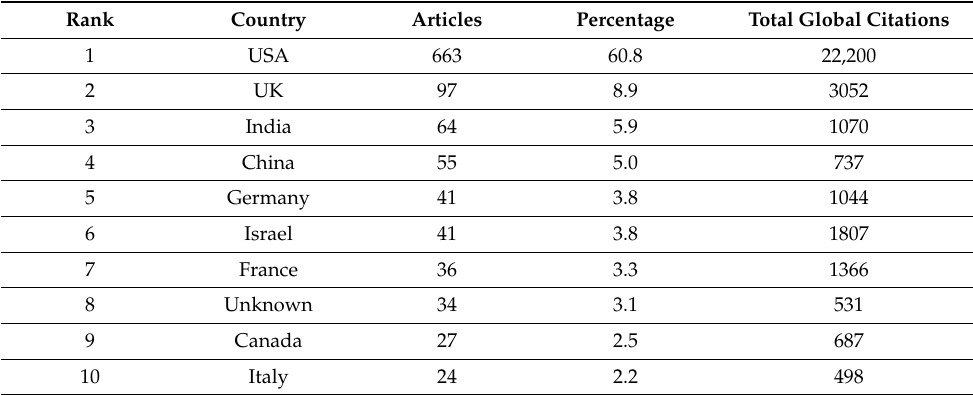
Table 7. Top 10 countries involved in anthrax vaccine research between 1991 and 2021.